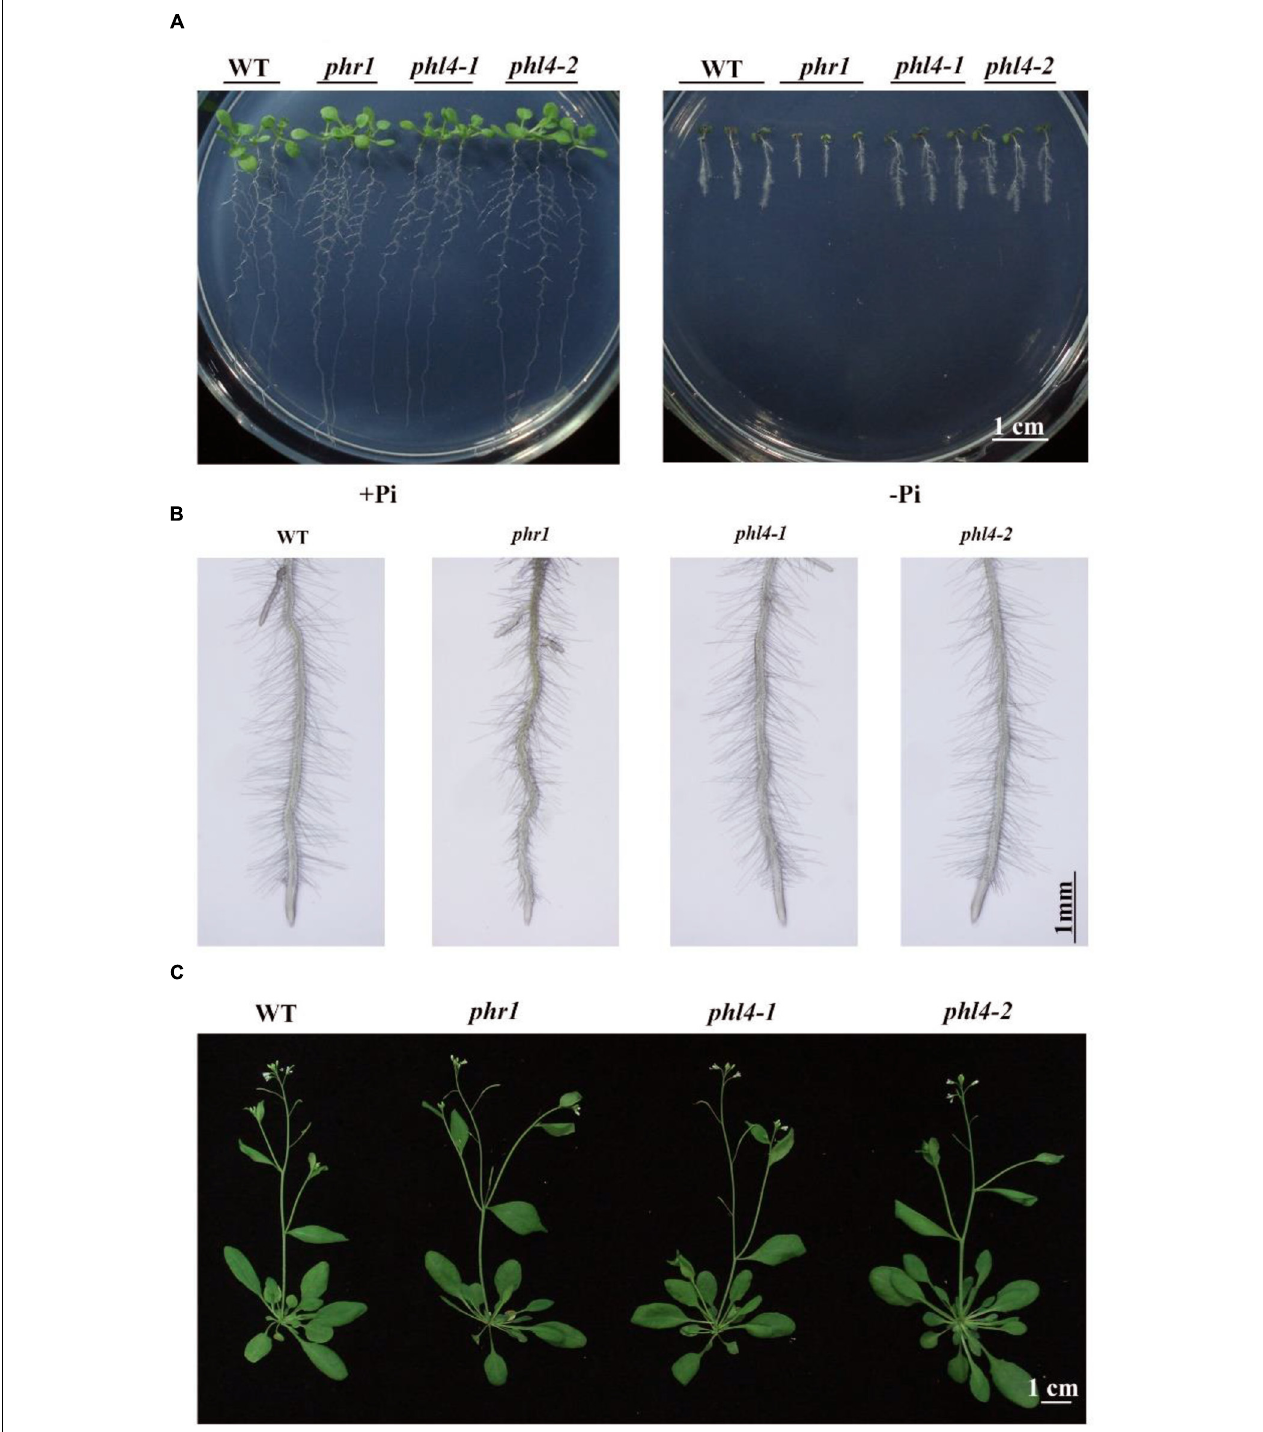
FIGURE 3 | Phenotypic analyses of two phl4 mutants. (A) Morphology of 10-day-old seedlings of the WT, phr1 , phl4-1 , and phl4-2 grown on +Pi and –Pi media. (B) Root hairs of 6-day-old seedlings of WT, phr1 , phl4-1 , and phl4-2 grown on –Pi medium. (C) Morphology of 5-week-old plants of the WT, phr1 , phl4-1 , and phl4-2 grown in